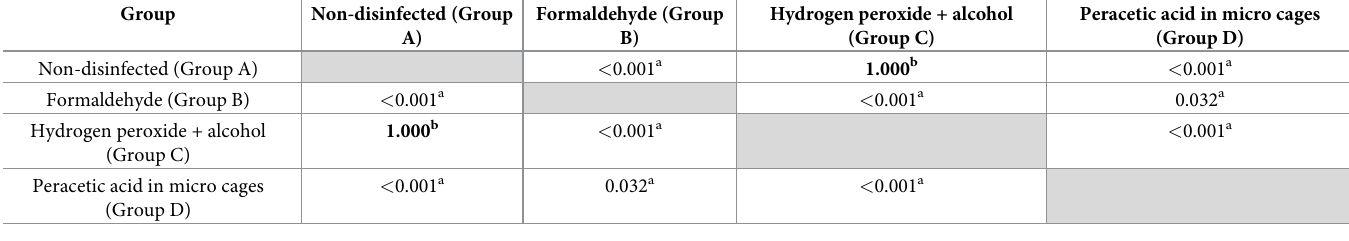
Table 2. Statistical data analysis of the different disinfection methods including non-disinfected as control group. The analysis was performed using the cfu/ml count of both flocks and two trials combined per group.